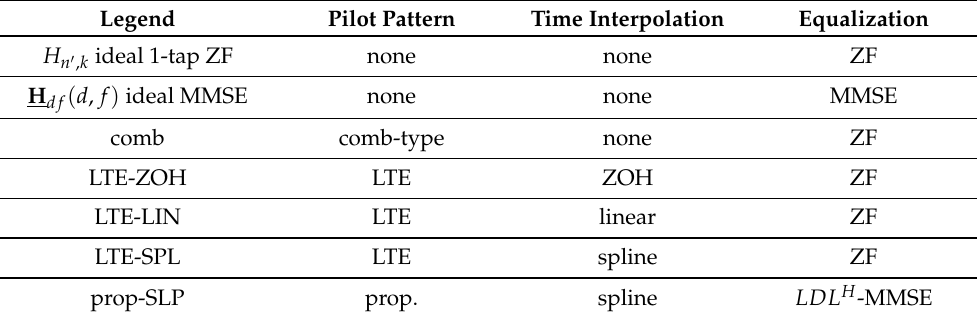
Table 2. Simulation